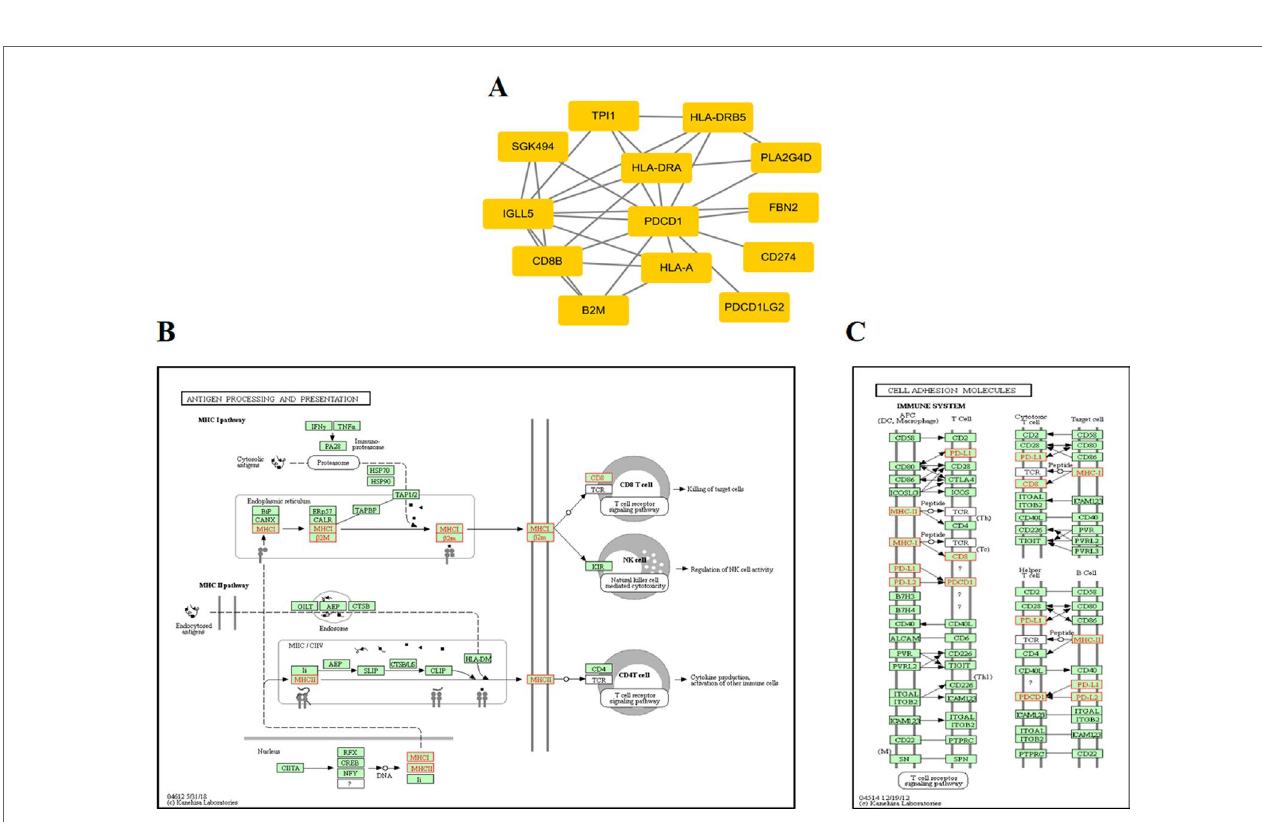
FIGURE 4 | Plot of mutation burden in specimens with hypermethylation and specimens with hypermethylation of top TMB-associated CpGs ( n (specimens) = 5